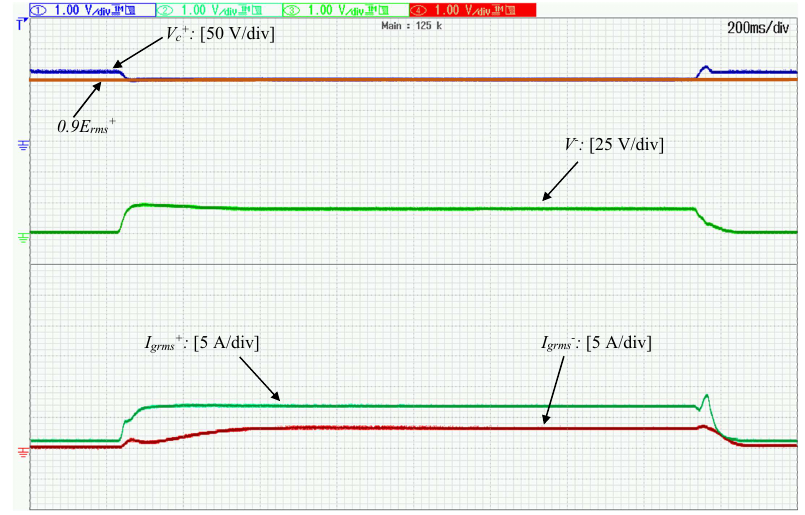
Figure 5. Operation under single-phase voltage drop ( V ga = 0.35p.u.): Positive and negative sequence RMS voltages and